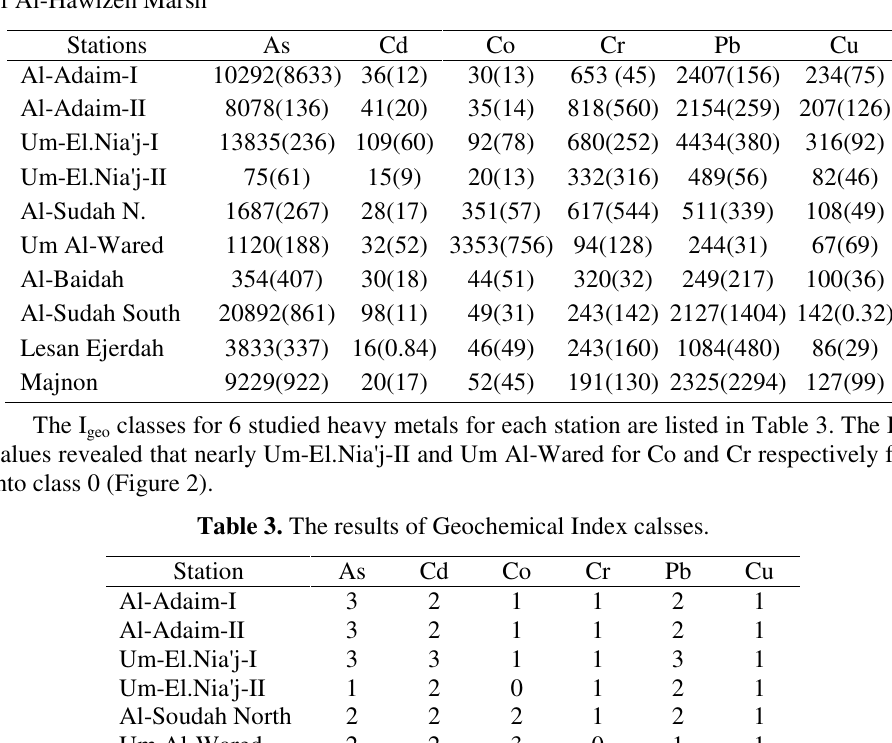
Table 2. The mean concentration (standard deviation) of heavy metals ( µ g/g) in sediments of Al-Hawizeh Marsh